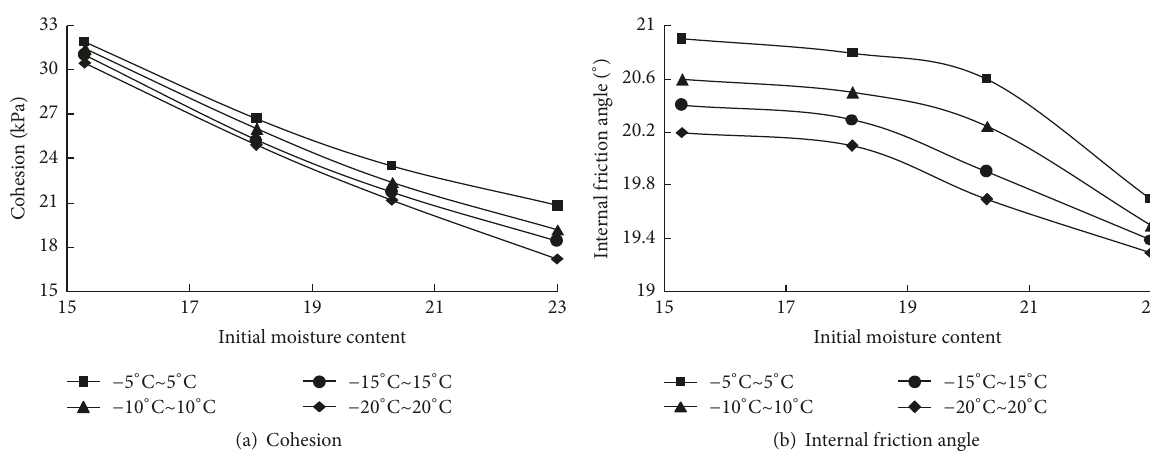
Figure 6: Relationship curve between initial moisture content and mechanical parameters.